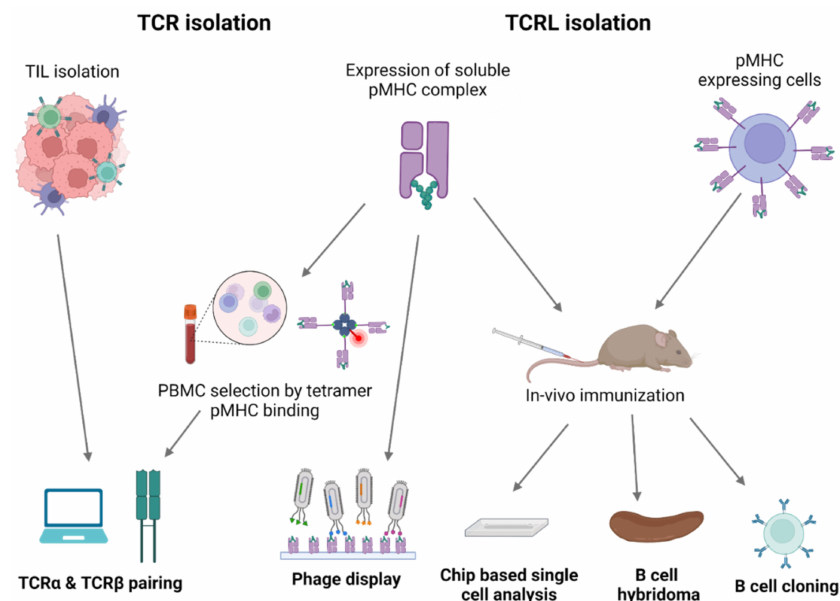
Figure 2. TCR and TCRL isolation methods. Illustration of TCR and TCRL identification and isolation process. TCR sequences targeting tumor-related pMHC dependent epitopes can be identified via isolation of TILs, present in the tumor environment, or via flow cytometry analysis of PBMCs, using fluorophore labeled pMHC tetrameric complexes. In both cases, computational analysis is required for TCR α and TCR β pairing. TCRL isolation can be achieved using phage display libraries, where phages are scanned against the pMHC of interest or by in vivo immunization, using recombinant pMHC molecule or pMHC expressing cells, followed by hybridoma analysis, B cell cloning, or chip-based single cell